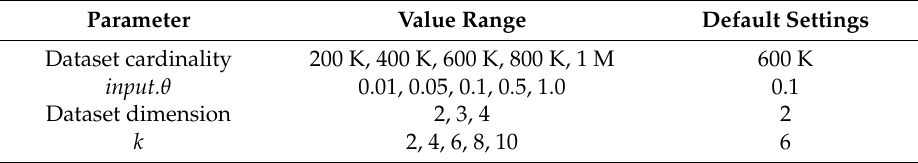
Table 3. Parameter